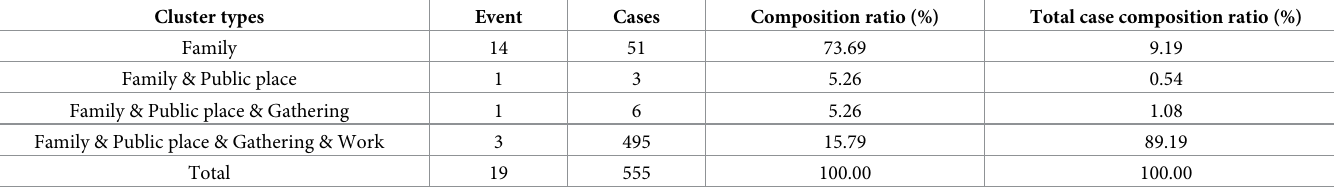
Table 2. Types of cluster